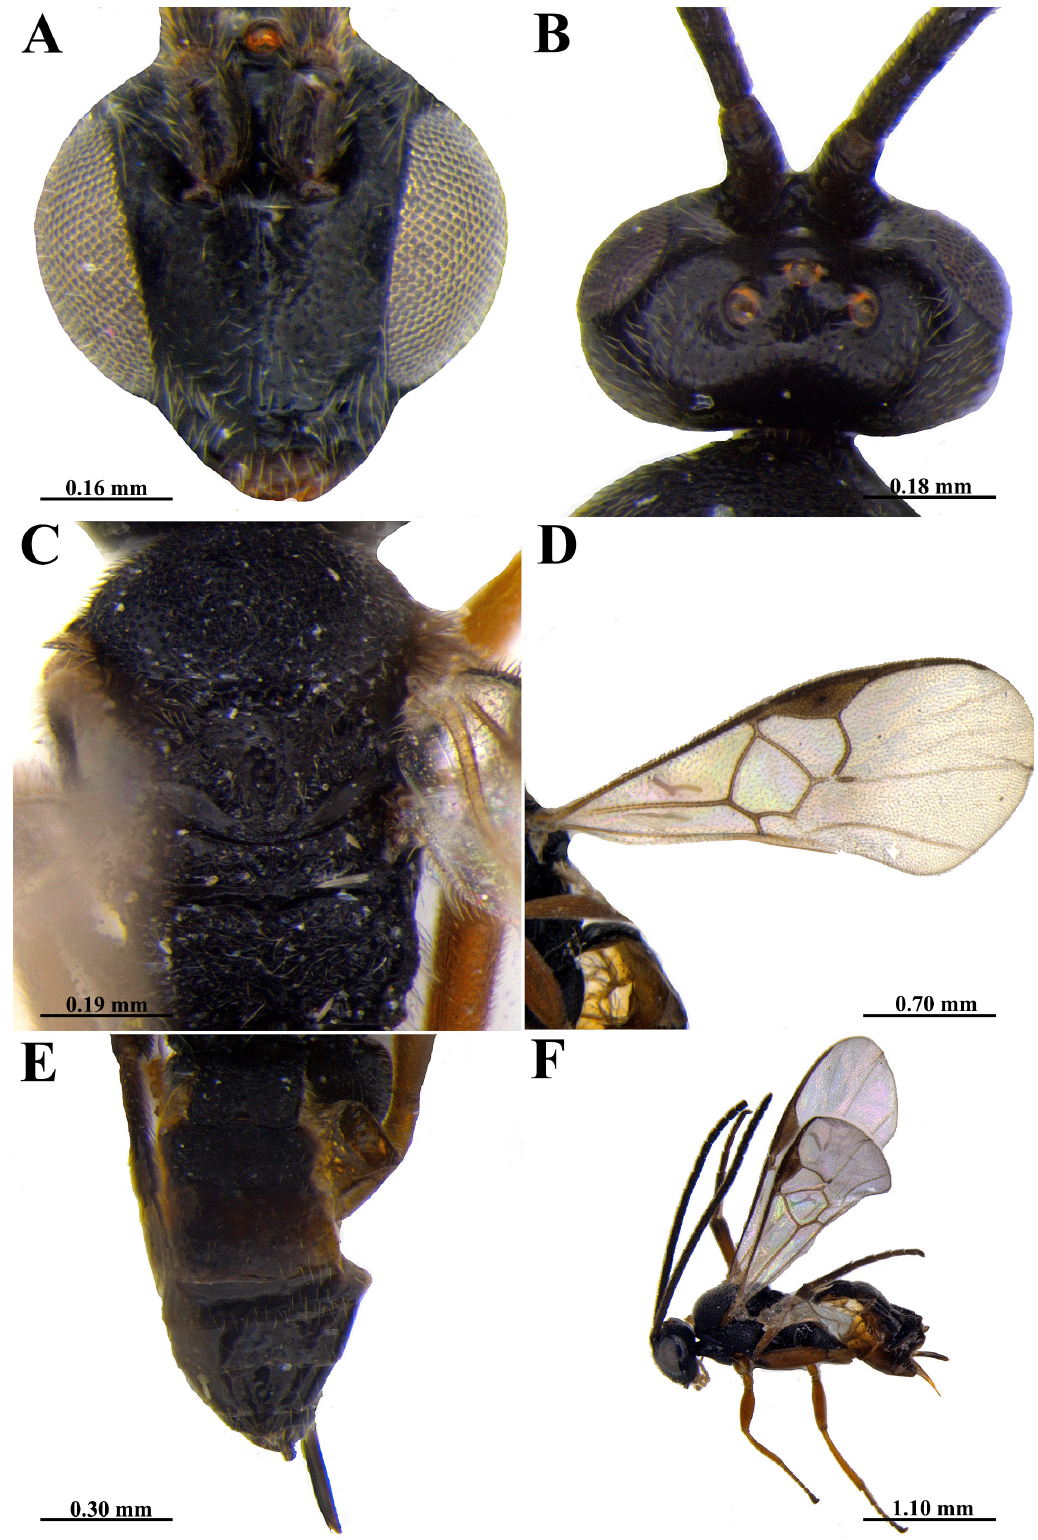
Fig. 2. Cotesia khuzestanensis Zargar & Gupta sp. nov., ICAR-NBAIR/NIM/MICROG/COT/451611. A . Head, frontal view. B . Head, dorsal view. C . Mesosoma, dorsal view. D . Fore wing. E . Metasoma, dorsal view. F . Habitus, lateral